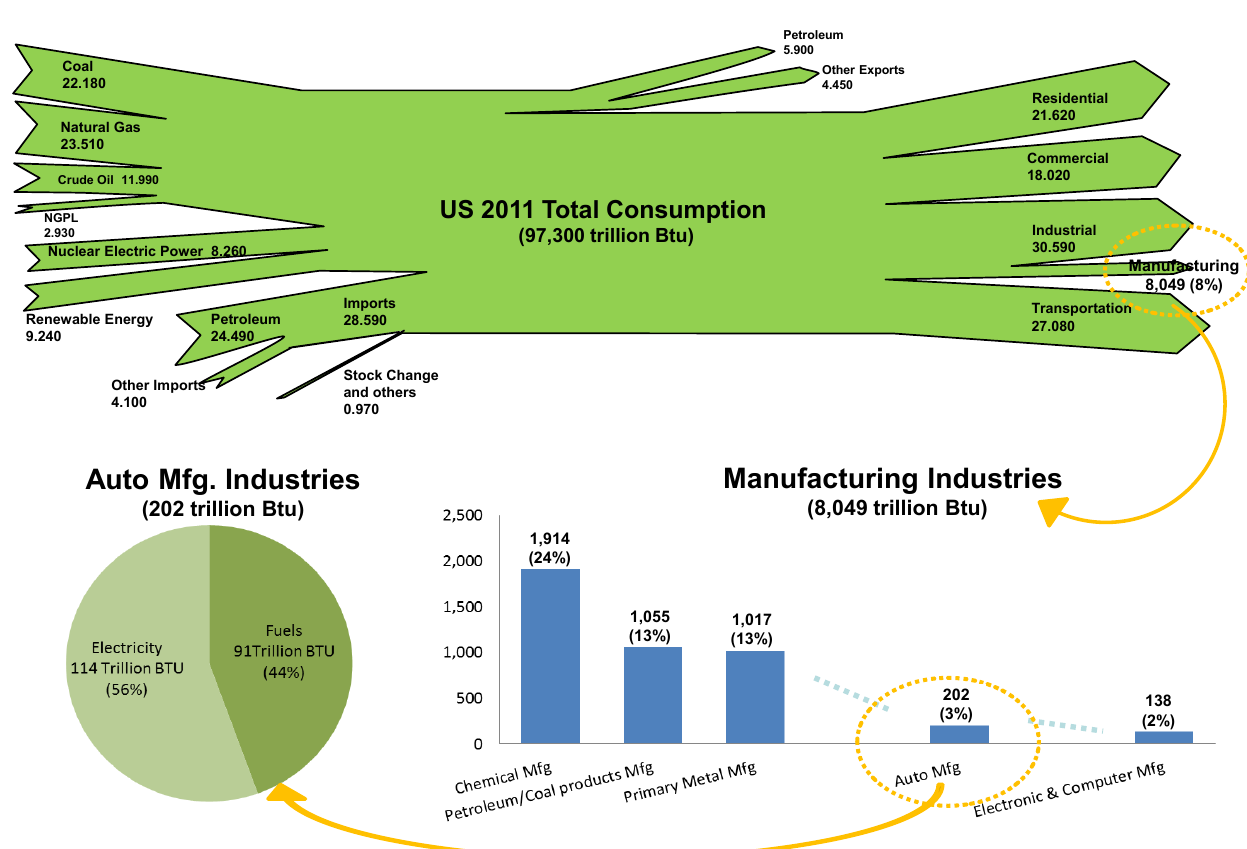
Figure 1. Energy flows into the US auto manufacturing industry 2011 (data sources: [1,2]).